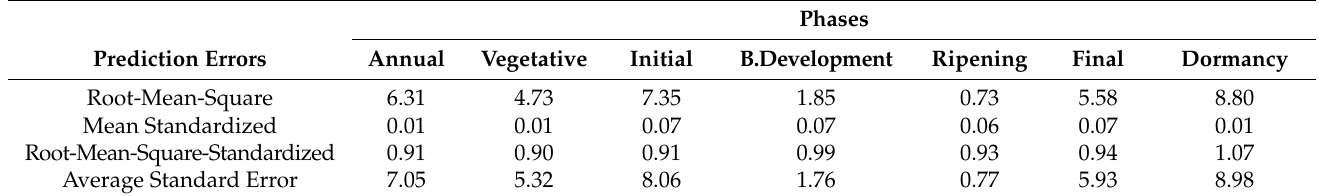
Table 3. Statistic for validation of each I DM map.